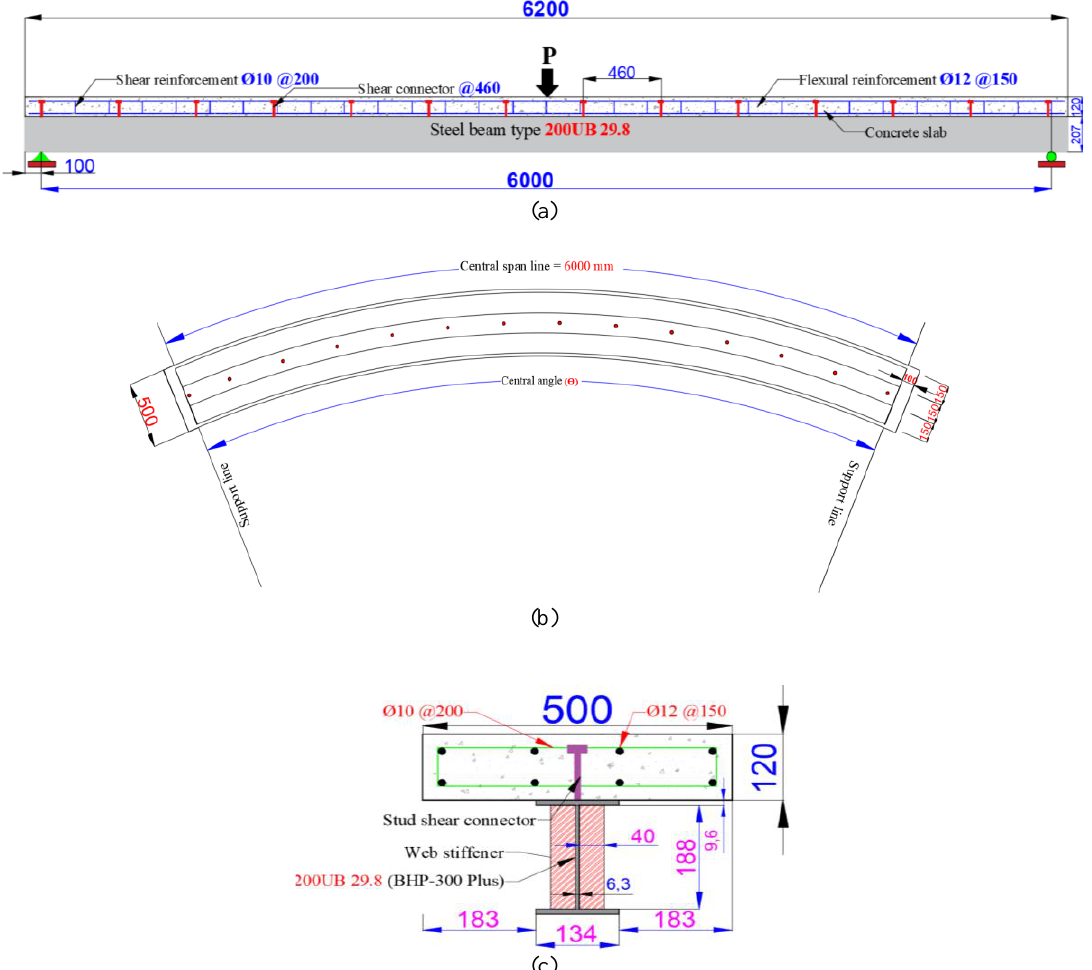
Figure 1. Geometry and dimensions of the curved composite steel—concrete beams CCBP-1, CCBP-2 and